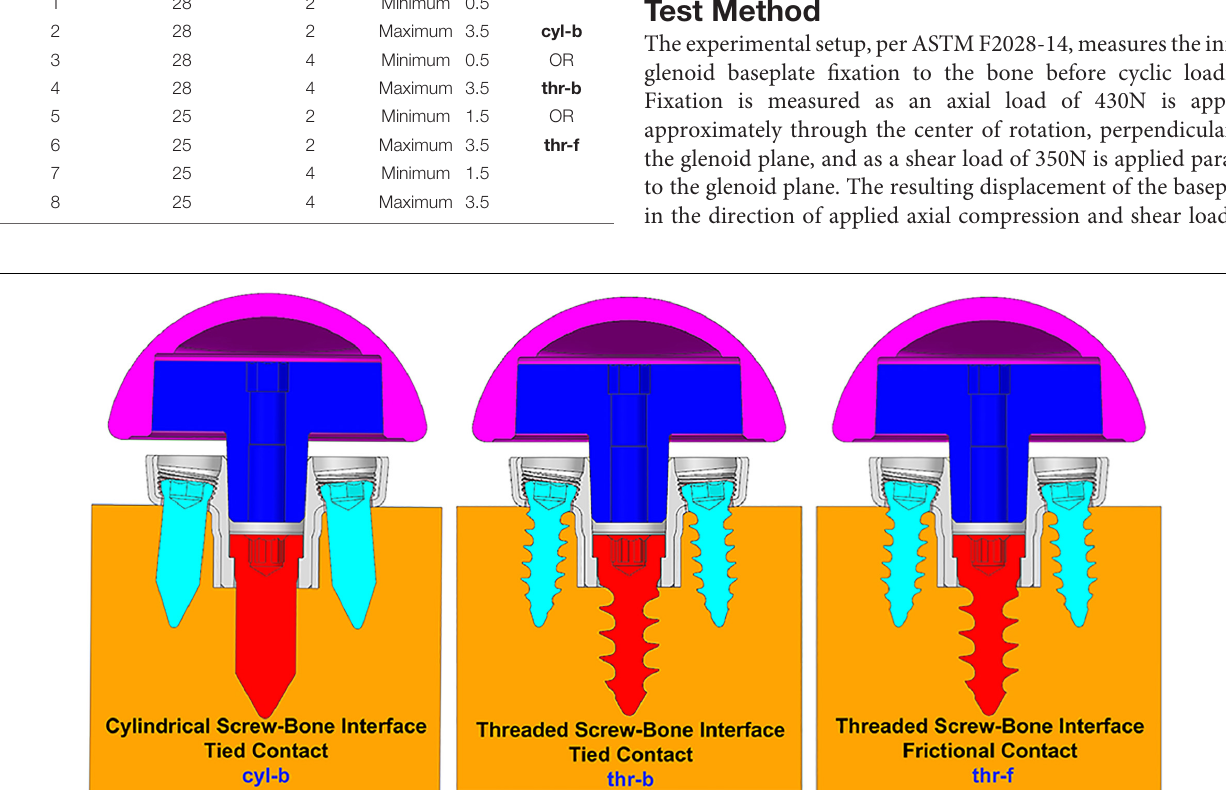
Frontiers in Physiology |